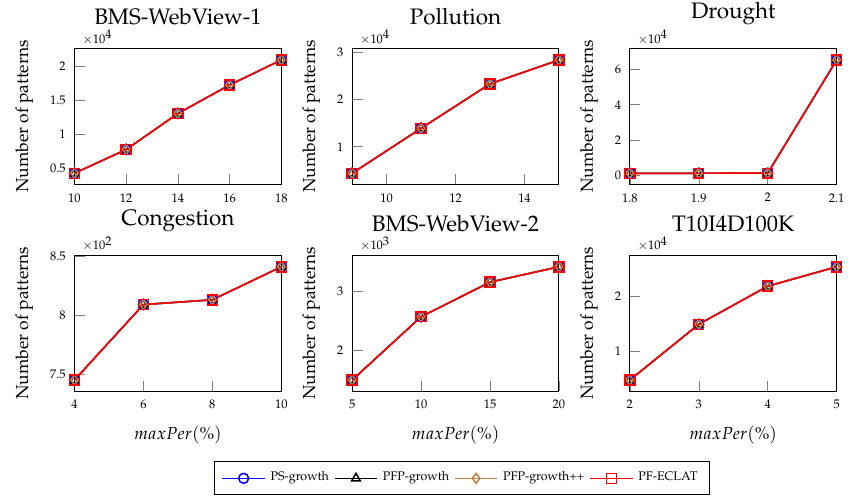
Figure 6. Patterns evaluation of algorithms at constant minSup